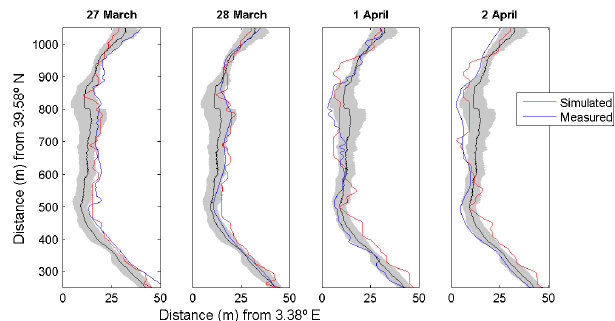
Figure 14. Modelled (red) and observed (blue) shorelines positions in Cala Millor with mean shoreline position (black line) and its stan- dard deviation (grey shadow) zoomed in to the central sector.